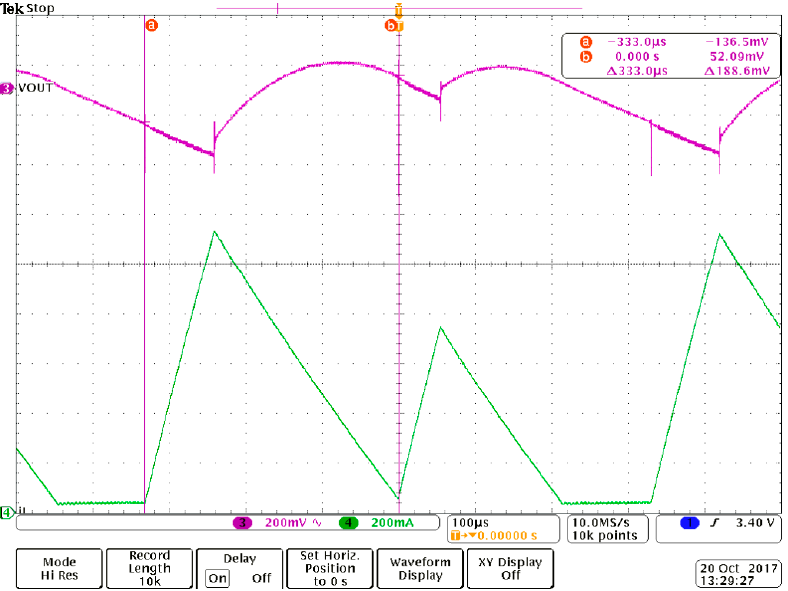
Figure 13. Inductor current and output voltage waveforms for k = 1.20. Bifurcation with period 2 operation is evident.